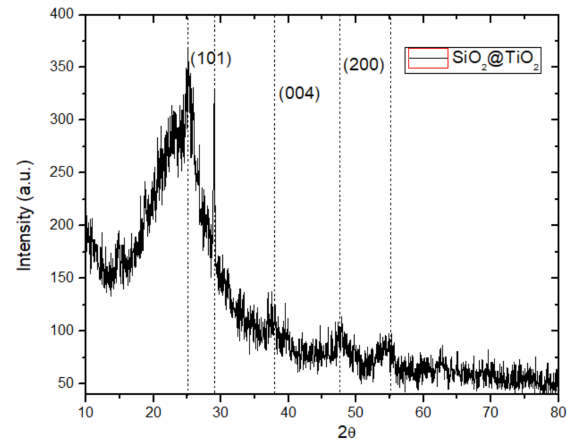
Figure 6. XRD pattern of the SiO 2 @TiO 2 coating.